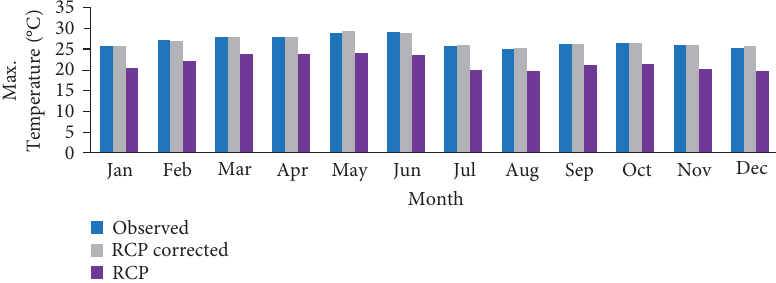
Figure 5: Bias correction of average monthly maximum